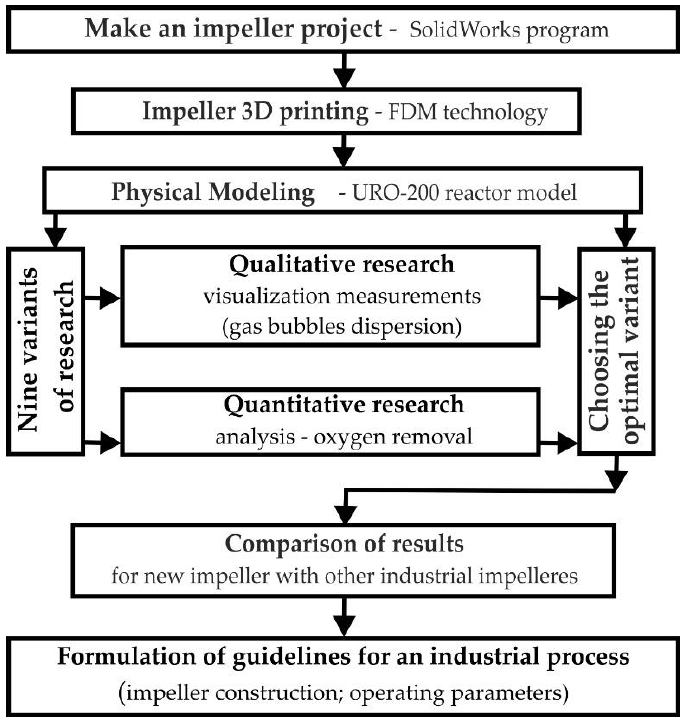
Figure 3. Research plan diagram.